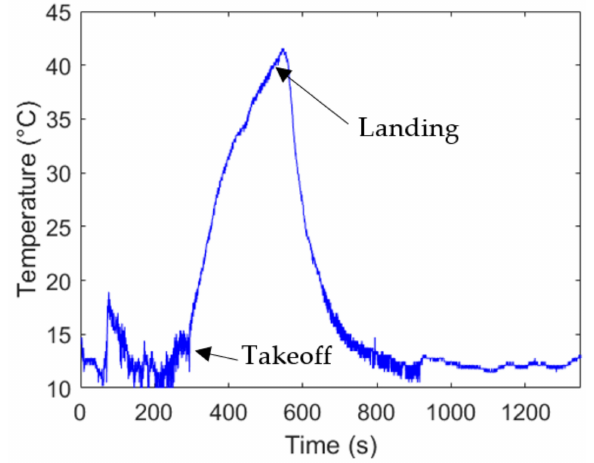
Figure 10. Thermocouple data at the